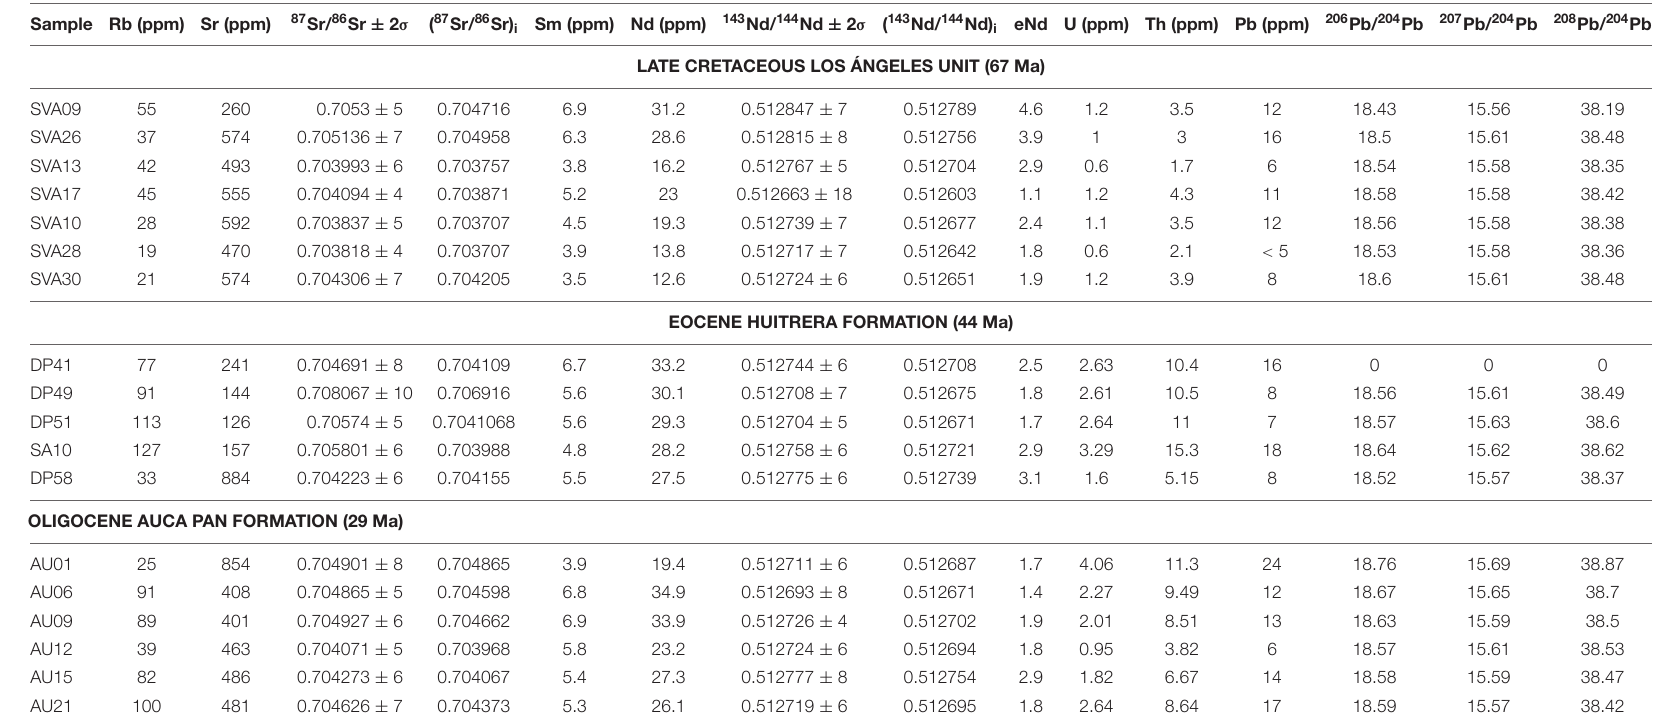
TABLE 1 | Initial Sr, Nd, Pb isotope ratioscalculated from the measurements of the current isotope ratios (TIMS), and Rb, Sr, Sm, Nd, U, Th, Pb element concentration of whole rock